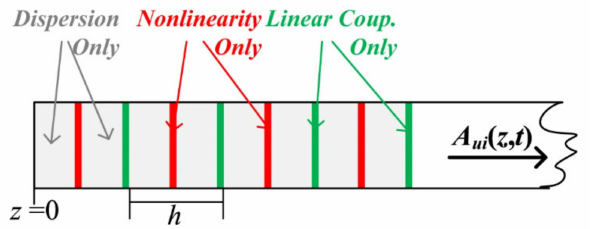
Figure 14. The symmetric SSFM for FMFs with linear coupling.